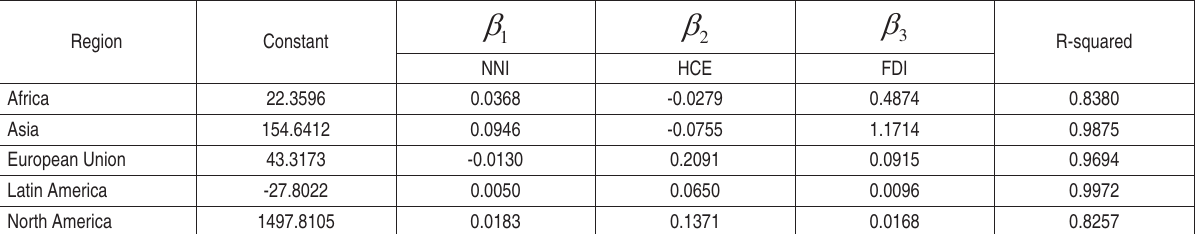
Table 4. Evaluation results of cooperation between expansion access to insurance services (FIIC) and financial and economic parameters (NNI, HCE, FDI) on the basis of distribution-lag models construction